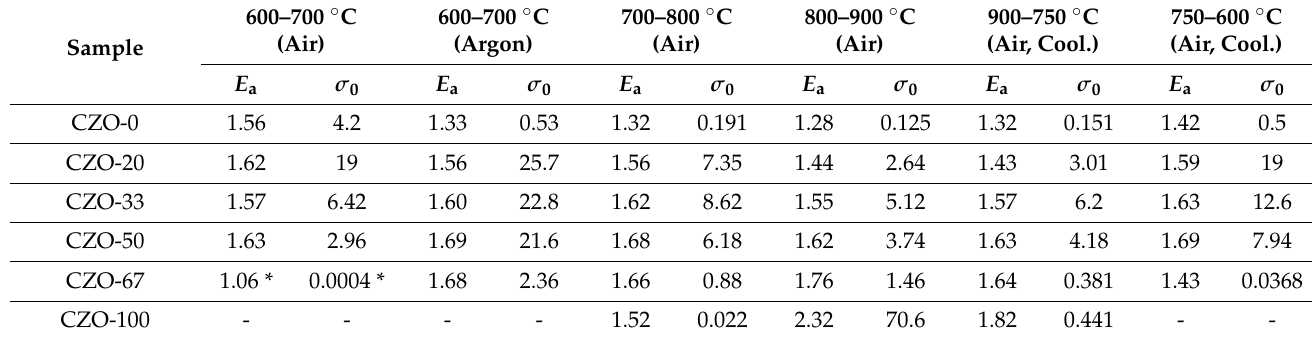
Table 2. Apparent activation energies E a (in eV) and pre-exponential factors σ 0 (in MS/m) of the electrical conductivity of Ce 1 − x Zr x O 2 thin films in air and in